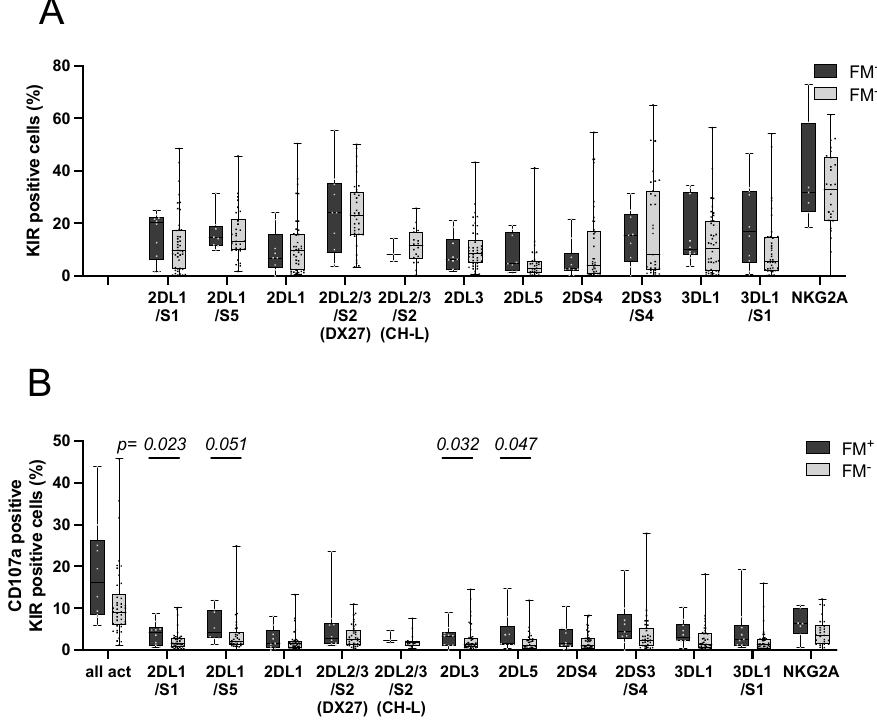
Figure 4. KIR expression in FM + and FM − mothers after co-culture with leukemic blasts. Maternal NK cells were isolated and IL-2/IL-15 pre-activated. The next day, cells were co-cultured with filial blasts in an E:T of 1:1 for four hours with addition of CD107a. After incubation, cells were stained with anti-KIR antibodies to determine the NK cell KIR phenotype. Mothers were grouped into FM + and FM − . ( A ) All cells positive for the respective KIR+, ( B ) CD107a+ activated cells of the respective KIR. For KIR2DL2/L3/S2, two different clones were used: DX27 and CH-L. FM + n = 3–10, FM − n = 31–42. Depicted are box and whiskers from min to max with each point representing one sample. Statistical analysis was performed using Mann–Whitney U test for comparison of FM + to FM − groups. Significance level p <